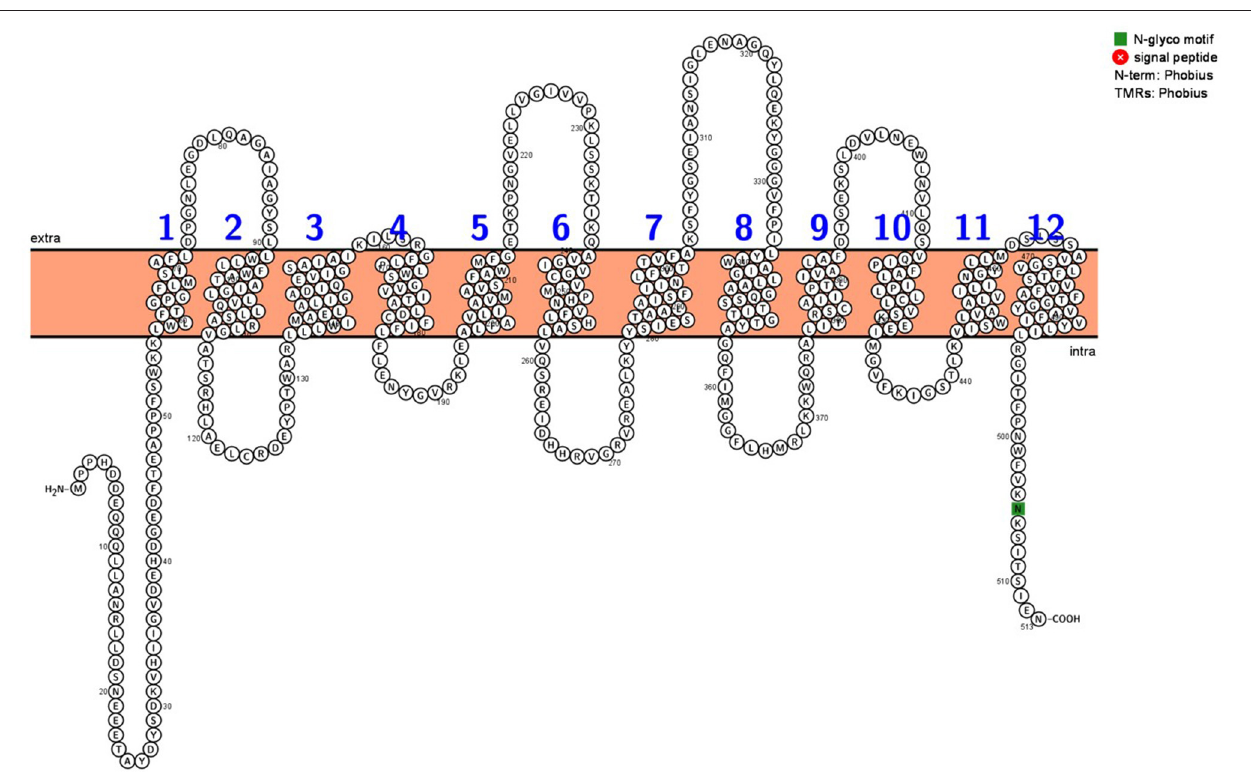
FIGURE 2 | Predicted transmembrane topology map of NtNRAMP3. The topology map was generated using the web-based Protter software (Omasits et al., 2014). NtNRAMP3 protein structure is comprised of 12 transmembrane regions and one N-glycosylation motif at amino acid position 505 (in green). N- and C- ends of NtNRAMP3 protein are located